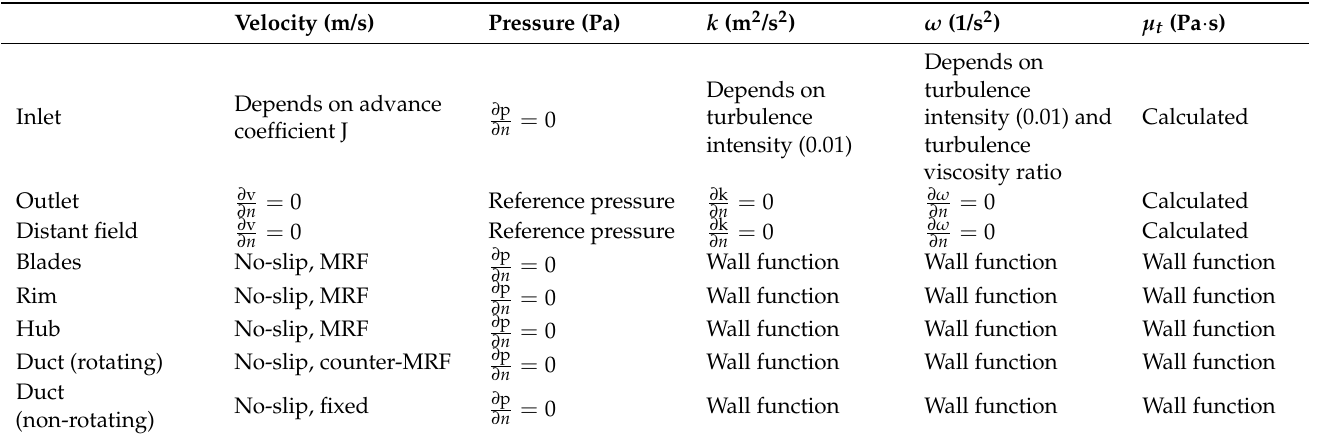
Figure 3. Computational domain for the RDT simulation. Table 2. Boundary conditions of the computational domains.